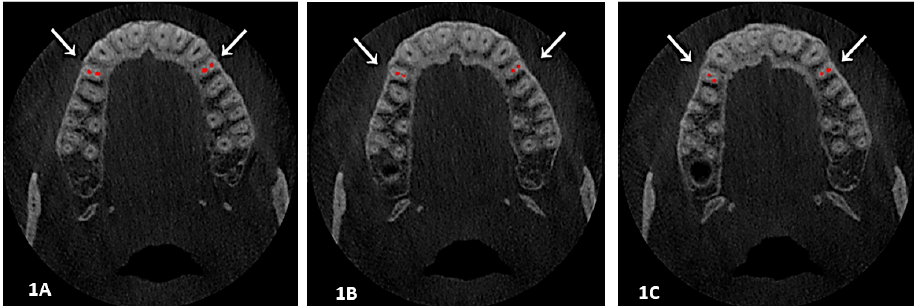
Figure 1. ( 1A , 1B and 1C ): An axial view showed a root canal system at different levels; here is an example of two canals with two foramen at three levels, Section ( 1A ) at orifice, while Section ( 1B ) is at the coronal-middle third, and Section ( 1C ) is at the foramen level. Classification codes came as Vertucci IV, 2 FP B 1 P 1 .